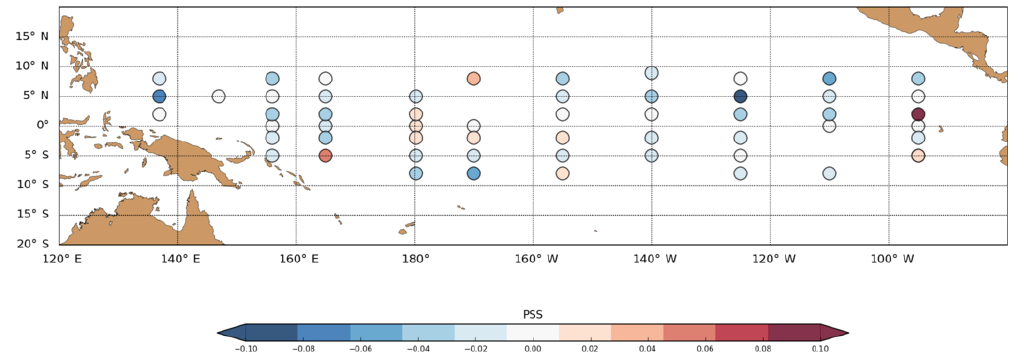
Figure 16. Difference in model salinity RMSE (pss) at 1m depth calculated against the 1m depth TAO mooring salinity values (SMOSexp – REF) calculated over the period 1 January 2014 to 16 March 2016 (negative/positive difference implies a reduction/increase in RMSE by the SMOS assimilation). Moorings are only included if they have more than 1 week of measurements during the period.